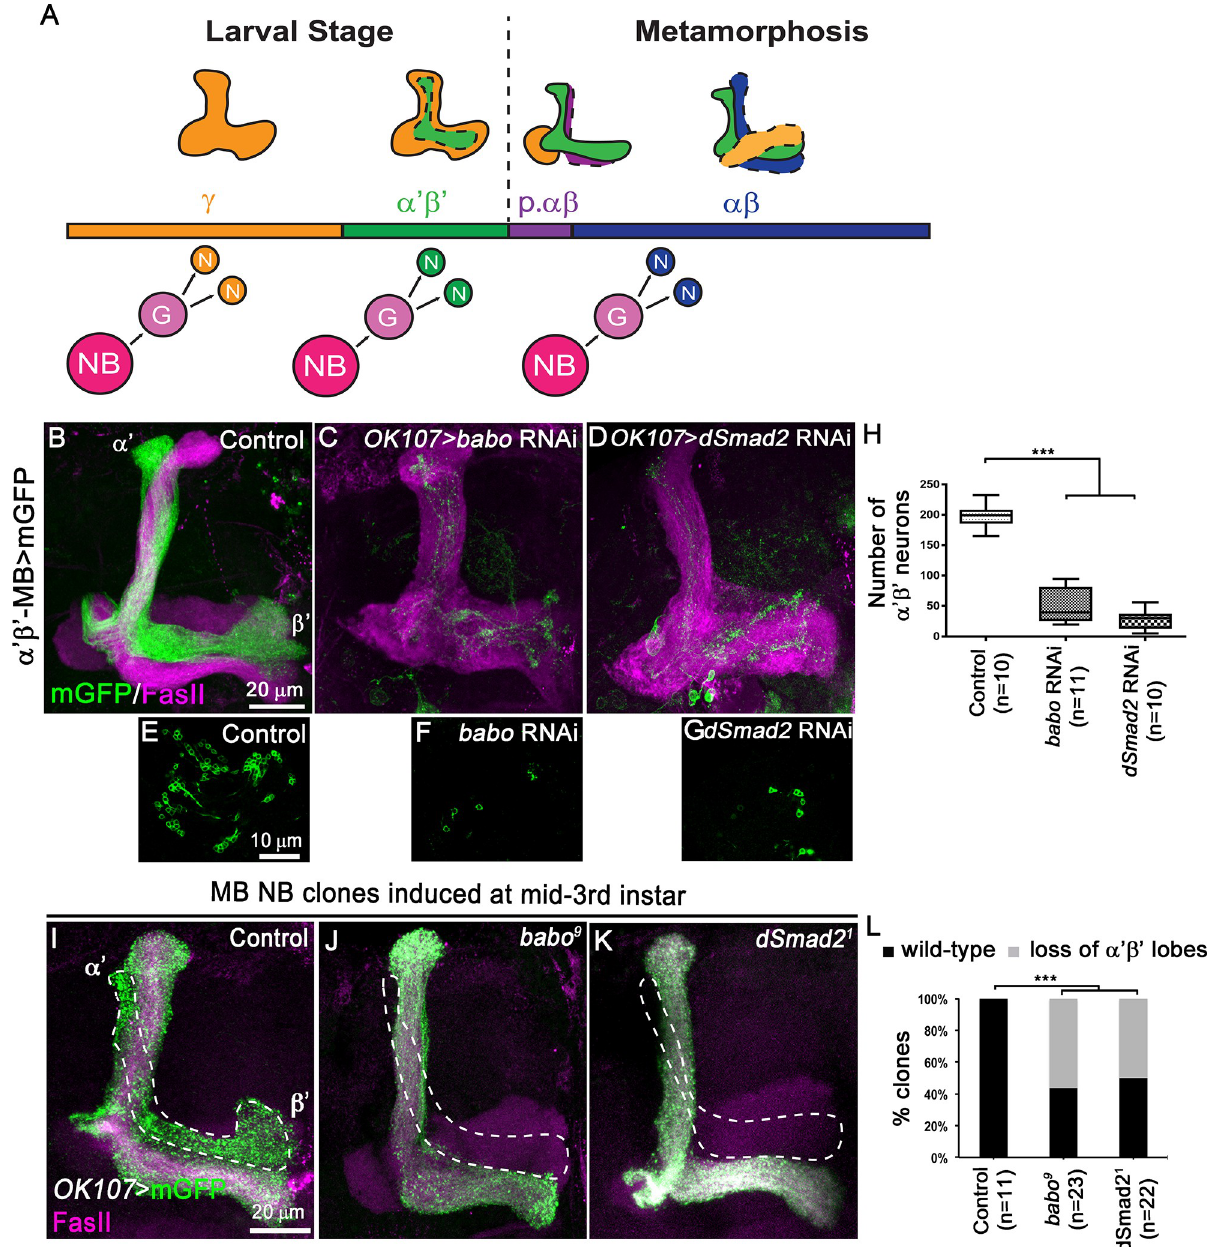
Fig 1. TGF- β signalling controls α ’ β ’ MB neuron fate specification. (A) Schematic drawings representing the sequential generation of the four distinct subtypes of MB neurons, which can be classified based on their axonal projection patterns (orange, γ neurons; green, α ’ β ’ neurons; purple, pioneer αβ neurons; blue, αβ neurons). MB neuroblasts (NBs) undergo multiple rounds of asymmetric divisions to generate ganglion mother cells (G) that in turn divide to produce two postmitotic neurons (N). (B-D) Adult MB lobes from control (B), OK107 > babo RNAi (C) and OK107 > dSmad2 RNAi (D) brains stained with anti-FasII antibody (magenta). (E-G) Single confocal section thought the cell body cluster of adult MB neurons from control (E), OK107 > babo RNAi (F) and OK107 > dSmad2 (G) brains. Green: GMR26E01 - LexA- α ’ β ’ - MB-driven mGFP (mCD8::GFP) in B-G. (H) Quantification of the number of adult α ’ β ’ MB neuron cell bodies from control, OK107 > babo RNAi and OK107 > dSmad2 RNAi brains. Statistical comparison to the control: ��� , p < 0.001 (two tailed t test). (I-K) Adult MB lobes from control (I), babo 9 (J) and dSmad2 1 (K) neuroblast MARCM clones generated at mid-third instar, labelled with mGFP (green) using the GAL4- OK107 driver and stained with anti-FasII antibody (magenta). (L) Quantification of α ’ β ’ MB fate defects in control, babo 9 and dSmad2 1 neuroblast clones. Statistical comparison to the control: ��� , p < 0.001; (Fisher’s exact